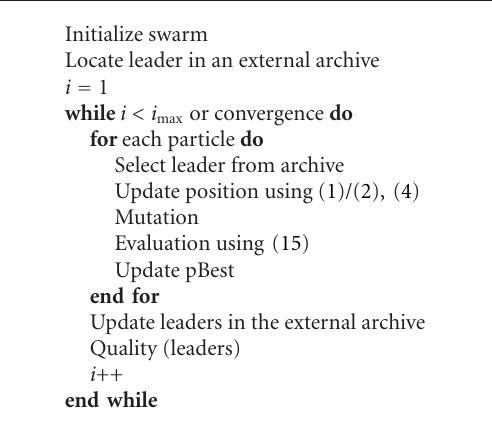
Algorithm 3: Multiobjective PSO